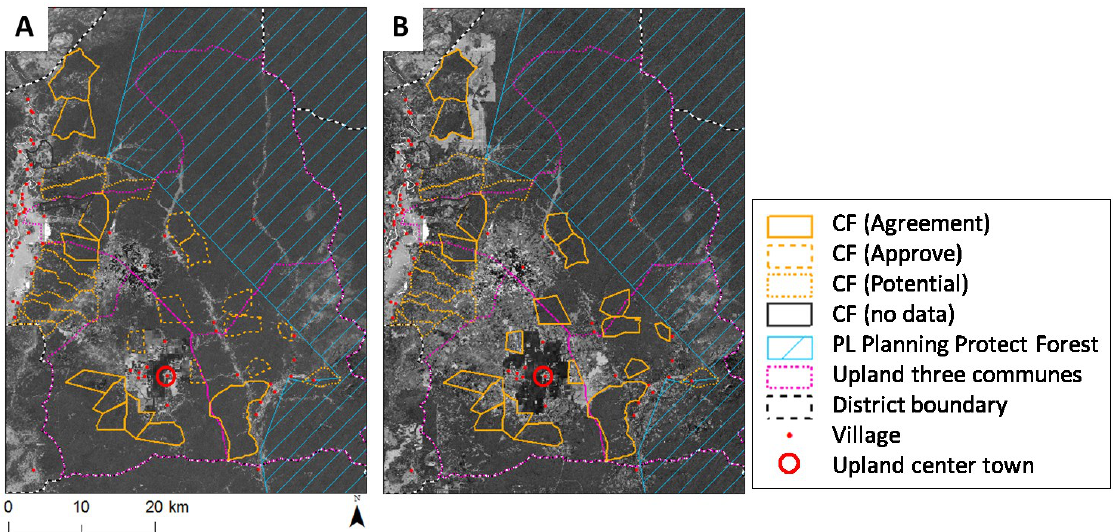
Figure 3. Recent changes in land cover and community forestry (CF) site status in Sandan District, Kampong Thom Province. Source: NDVI of ( A ) Landsat 5 TM taken on 14 January 2009 and ( B ) Landsat 7 taken on 11 January 2014. CF statuses for ( A , B ) were available from the Kampong Thom provincial office of the Forestry Administration and are based on the periods of June 2010 and September 2014,